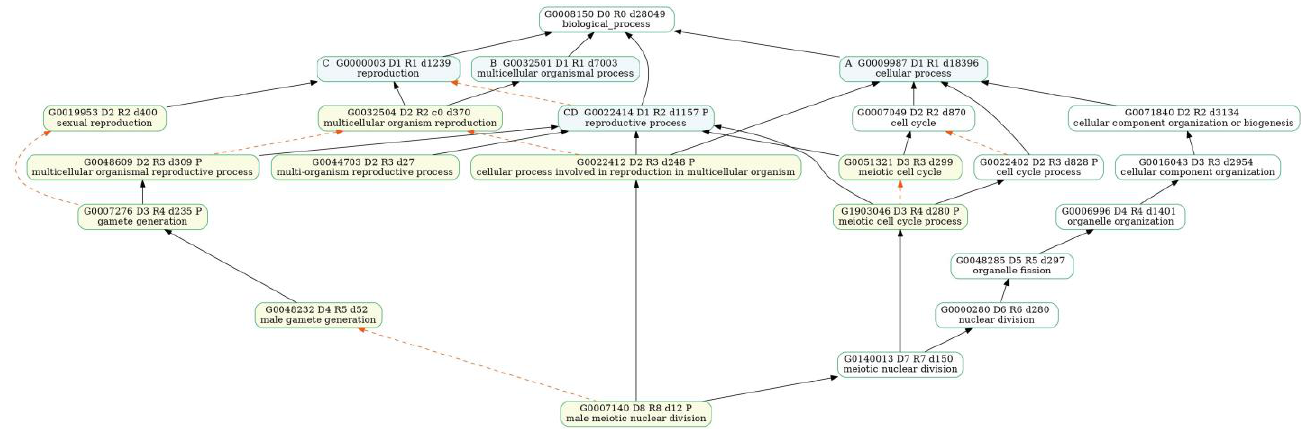
Figure 11. GOATOOLS [40] analysis of GO biological process association maps enriched in the second stage of female flower buds. The plot shows that GO terms enriched in the results (yellow) are associated with reproductive processes (blue).